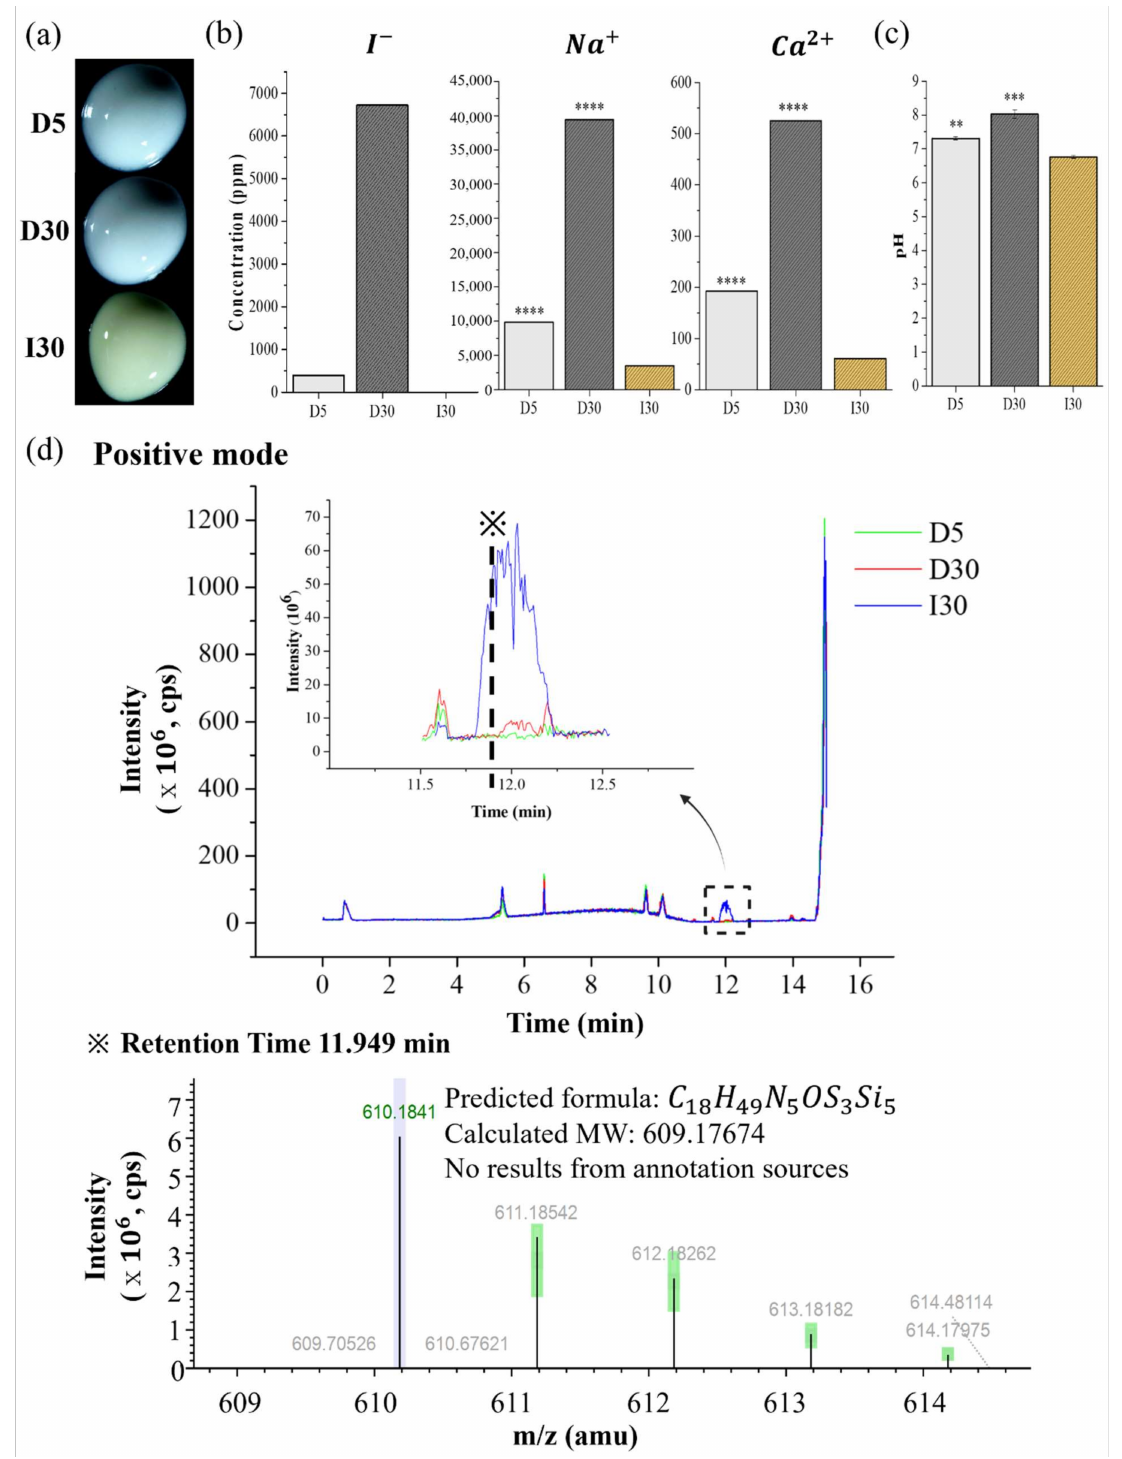
Figure 2. Optical images and extraction analysis of NaI-incorporated paste (NaI@P). ( a ) Optical images. ( b ) Iodine, sodium, and calcium ion releases. ( c ) The pH. ( d ) Molecules extracted by liquid chromatography/mass spectrometry (LC/MS) ( m / z = mass to charge ratio). Statistical significance was calculated using one-way analysis of variance (ANOVA) followed by Tukey’s honest significant difference compared to the control (I30). ** p < 0.01, *** p < 0.001, **** p <